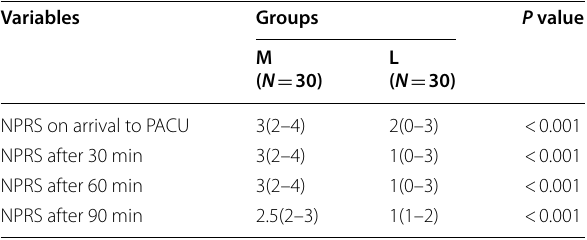
Table 3 Numeric Pain Rating Score (NPRS) in the post‑ anesthesia care unit (PACU)